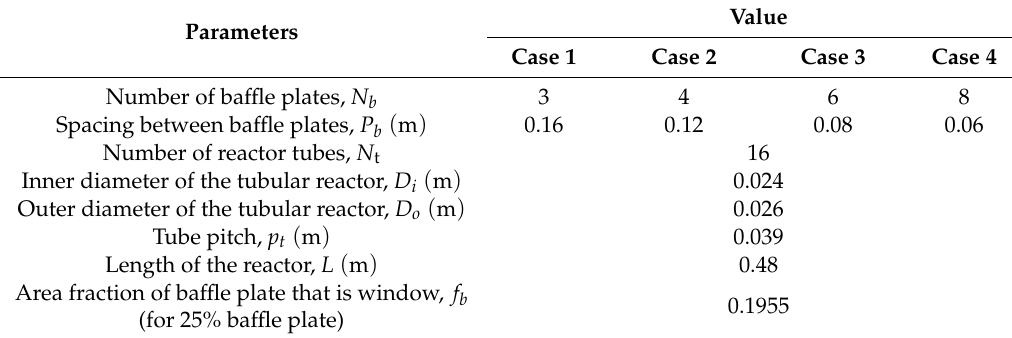
Table 7. Geometric parameters of the packed-bed reformer with variation in the number and pitch of ba ffl